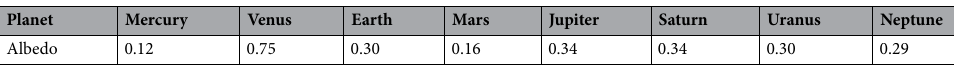
Table 1. Planets with their respective average Albedos. Sources: Idrisi and Ullah 22